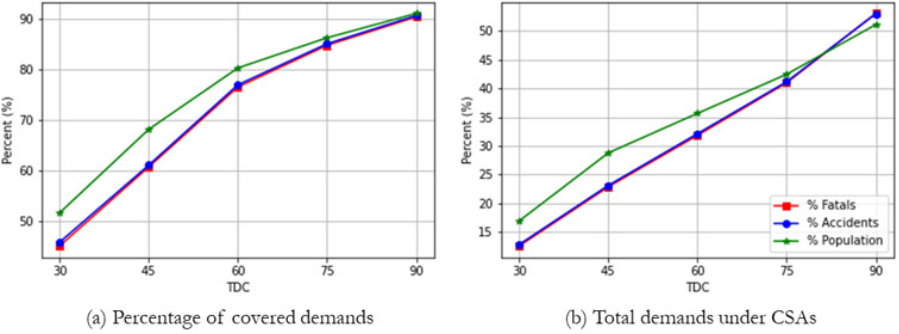
Figure 6. Potential demands covered by trauma centers in Tennessee, 2019. ( a ) Percentage of cov ‐ ered demands; ( b ) Total demands under CSAs. demands; ( b ) Total demands under